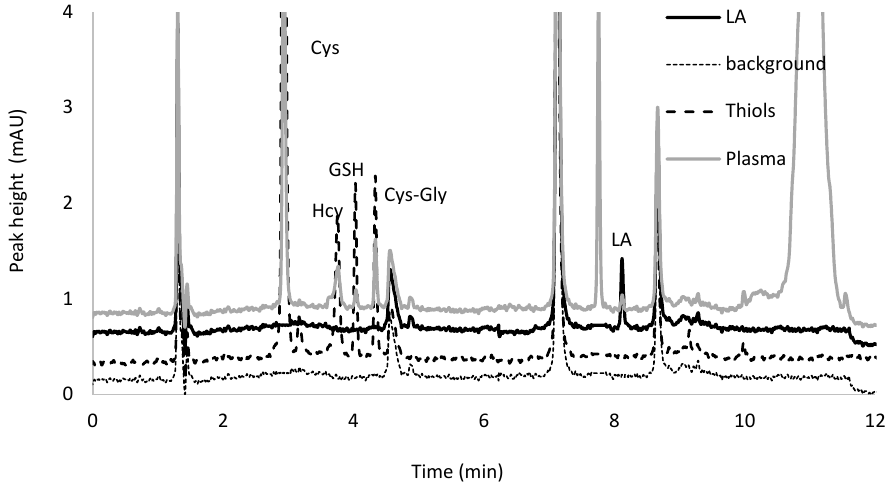
Figure 7. Typical chromatograms of background, pyridinium derivatives of α -lipoic acid, oxidized glutathione, cystine, cysteinylglycine and homocystine after simultaneous reduction and derivatization in proxy matrix spiked with analytes and plasma samples collected from an apparently healthy adult.